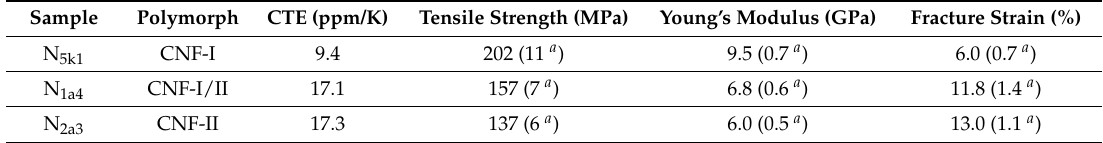
Figure 8. Tensile stress-strain curves of CNF-I, CNF-I/II, and CNF-II films. Table 2. Average tensile properties of CNFs with different polymorphs.